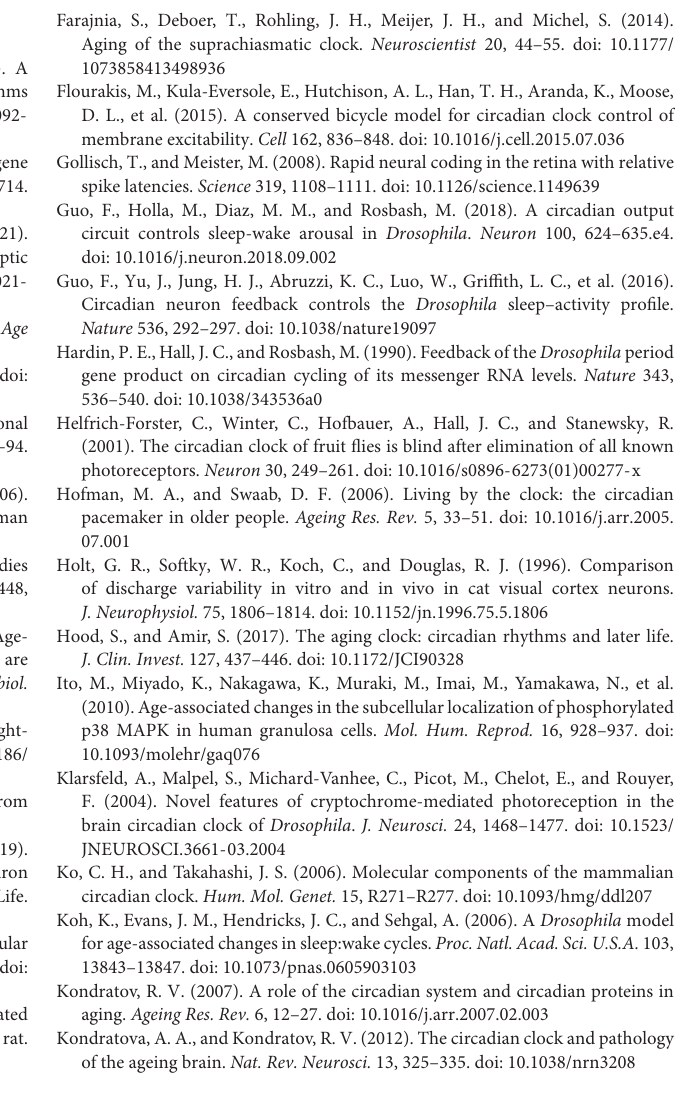
Supplementary Figure 1 | Histogram of the distribution of interspike intervals during spontaneous firing activity in DN1p neurons (same data used in Figures 1 , 2 ). Supplementary Figure 2 | Continuous wavelet transform heatmaps showing scaled and normalized oscillatory amplitude according to frequency and time (same data used in Figures 1 , 2